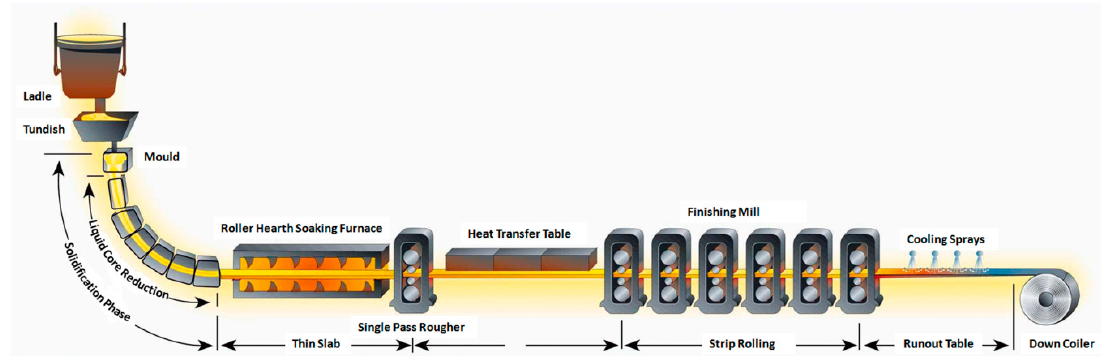
Figure 1. Thin slab casting direct strip production complex at Algoma Inc. [3].